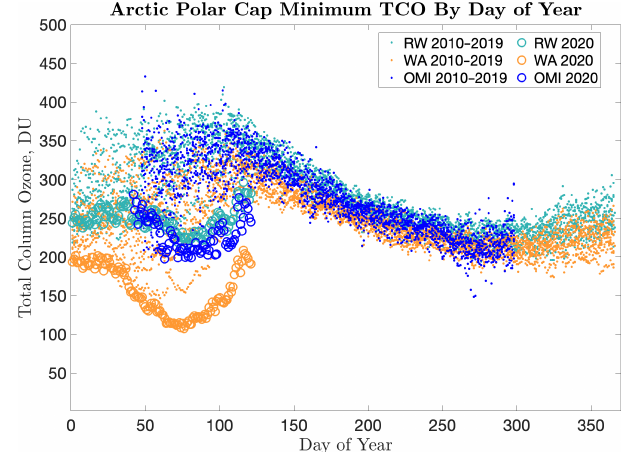
Figure 5. Minimum total column ozone simulated by SD-WACCM from 70 to 90 ◦ N from January 2010 through the end of April 2020, plotted by day of the year. Teal markers refer to the reference run and orange markers to the WA run. Blue markers refer to observa- tions by the OMI satellite. Dots indicate days from 2010 to 2019, and open circles indicate days in